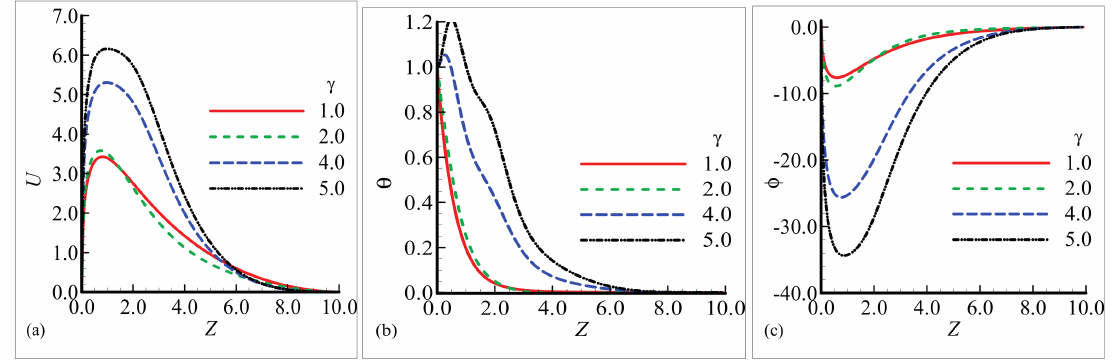
Figure 13. Physical e ff ects on quantities ( a ) u , ( b ) θ , and ( c ) ϕ versus Q, when Nt = 0.1, Nb = 0.4, Pr = 0.71, M = 0.2, Sc = 0.2.